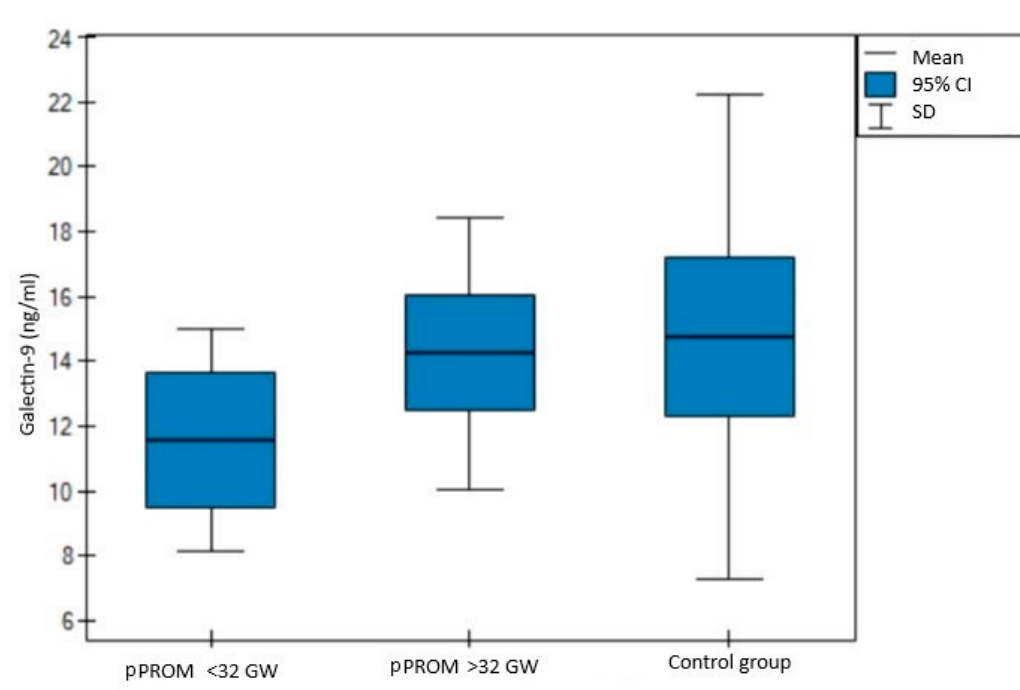
Figure 4. Comparison of three independent groups for galectin-9.